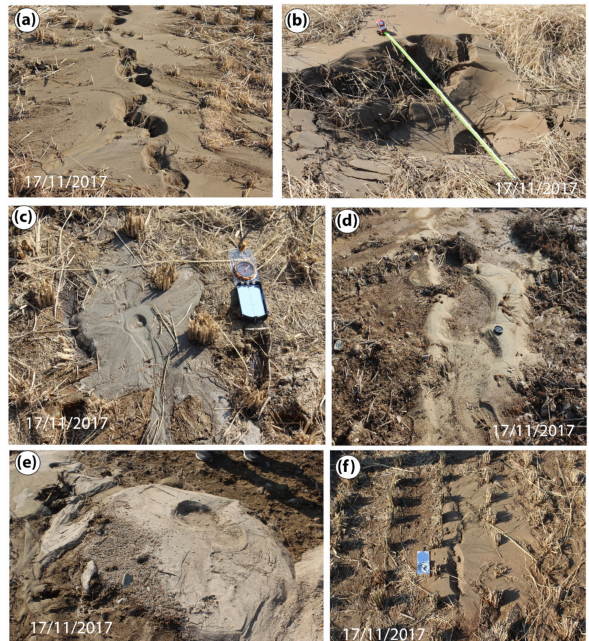
Figure 4. Field photos from Youngcheon-ri and Mangcheon-ri showing ( a ) linear sand boils as a chain; ( b ) isolated sand boil of around 2-m diameter; ( c ) small isolated and circular sand boil of around 60–70-cm diameter; ( d , e ) lenticular and circular sand boil showing evidence of sand and gravel mixture ejection; and ( f ) ejected sand boils through the